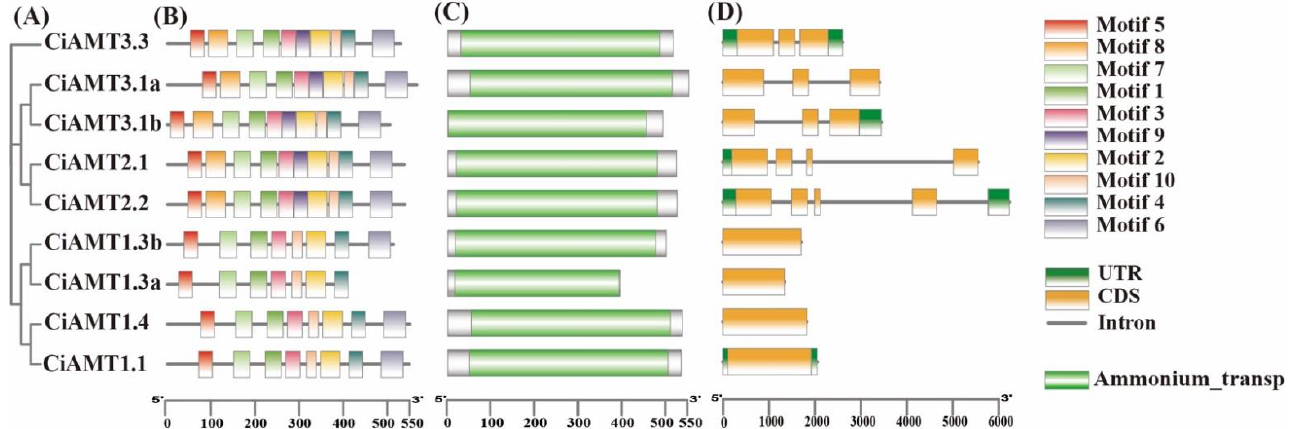
Figure 3. Phylogenetic analysis, conserved motif, conserved domain and gene structural of the AMT genes in pecan. Phylogenetic analysis of the AMT genes in pecan ( A ). The conserved motifs of the AMT genes in pecan ( B ). The conserved domain of the AMT genes in pecan ( C ). The gene structure of the AMT genes in pecan ( D ).